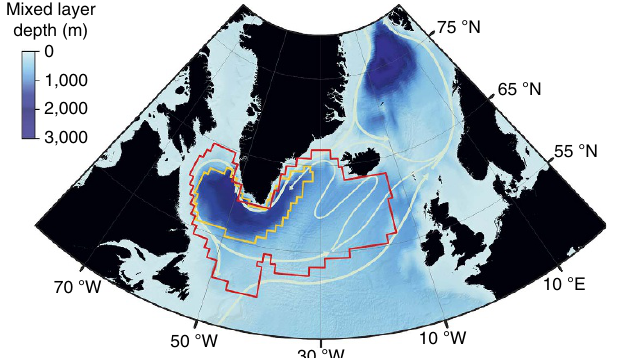
Figure 1 | Sites of deep-water formation in the North Atlantic. Map of the maximum winter mixed layer depth (m) averaged over the 1993–2012 period according to the GLORYS reanalysis. The red contour represents the reference area for our analysis (see Method s) . Its total surface measures 3.61 (cid:2) 10 6 km 2 and it entirely spans the subpolar NA, including those sites in the Labrador and Irminger Seas that are regularly subject to convective activity. The yellow contour highlights the region for which the maximum MLD averaged over the 1993–2012 period exceeds 1,000m. This area has been used for a sensitivity test of our main findings on the particular choice of the reference region (Supplementary Fig. 9). Arrows indicate the main surface currents, including the North Atlantic Current, the western subpolar gyre in the Labrador and Irminger Seas and the eastern subpolar gyre in the Nordic